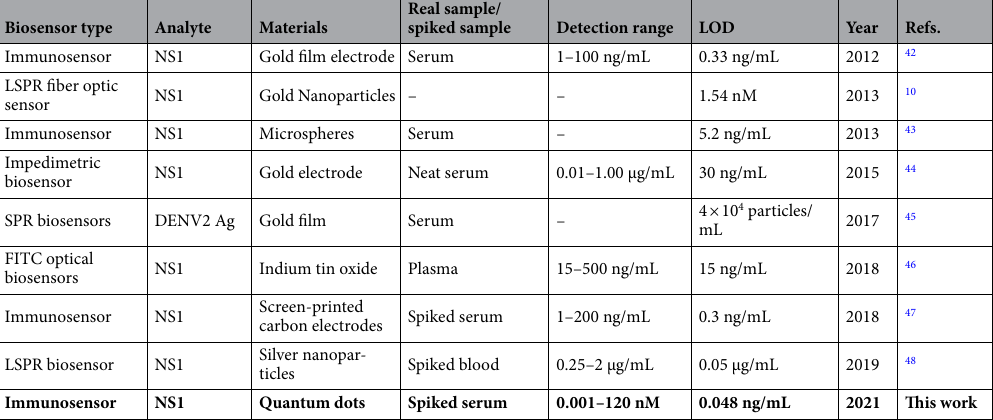
Table 2. Comparison of biosensor platforms and their LOD for dengue virus